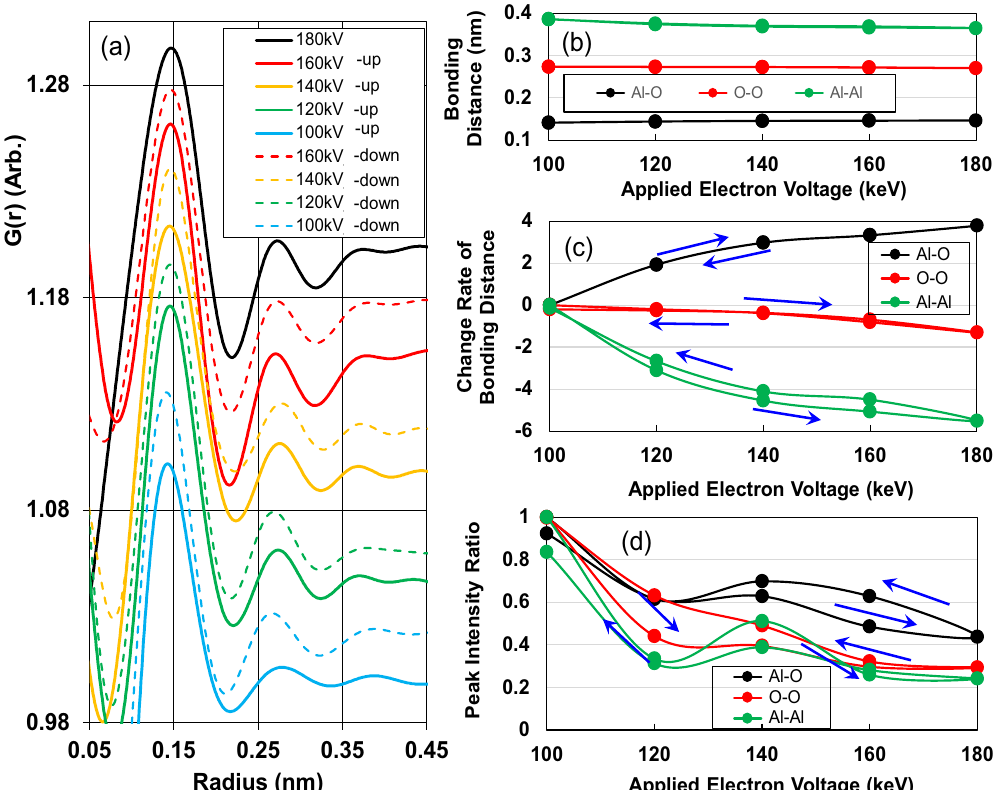
Figure 1. ( a ) Changes in atomic pair distribution functions (PDFs) under irradiation at 100, 120, 140, 160, and 180 keV with the dose rate of 6 nA/m 2 with increasing and decreasing voltage energy runs. ( b ) Bonding distances, ( c ) change rates of distance, and ( d ) intensity ratios for peaks of Al–O, O–O, and Al–Al bonds as functions of applied